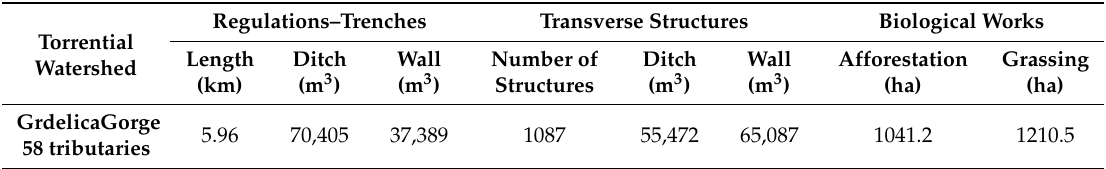
Table 4. Data on the works performed in the direct tributaries of the South Morava in the Grdelica Gorge region in the period from 1947 to 1977